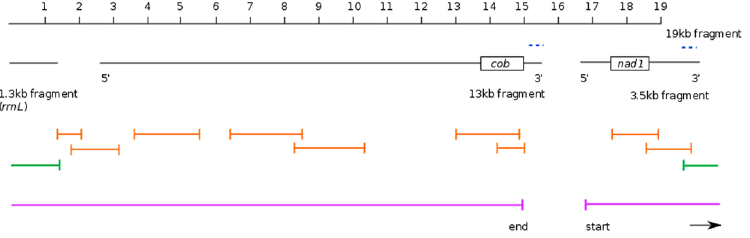
Figure 3. Overview of the initial transcriptome assembly fragments and PCR strategy for scaffolding the Isodiametra pulchra mitochondrial genome. 1.3 kb, 13 kb and 3.5 kb fragments aligned to a continuous 19 kb fragment, with the location of the duplicated sequence in the 13 kb and 3.5 kb fragments shown by blue dashed lines. The ‘start’ and ‘end’ regions of the 13 kb and 3.5 kb fragments are annotated by 5 ′ (start) and 3 ′ (end). The approximate location of cob and nad1 protein-coding sequence are shown for reference. Reliable PCR- amplicons are shown in orange; the green PCR fragment indicates successful joining of the 3 ′ end of the 3.5 kb fragment to the rrnL fragment, including the duplicated section. The 18,725 base-pair long sequence we resolve is indicated by the pink lines, from ‘start’ to ‘end’.